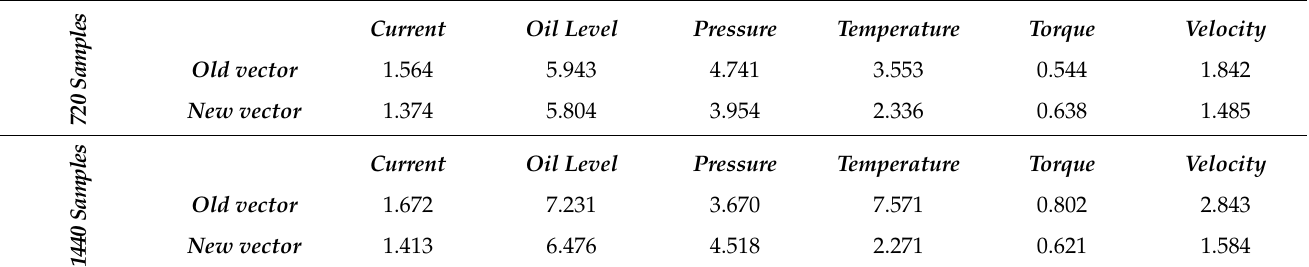
Table 4. Comparative MSE results between old vector and new vector.